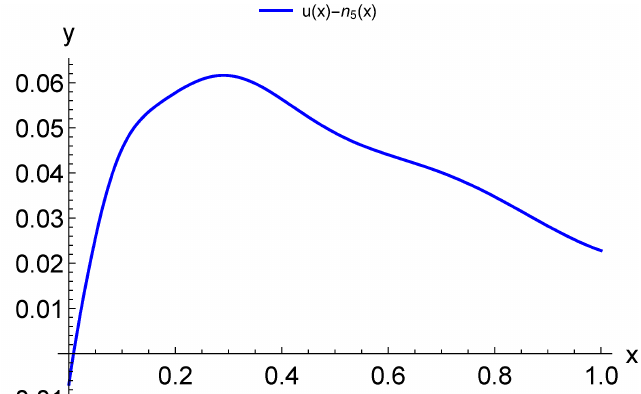
Figure 5. Plot of the error of the neural network solution n 5 ( x ) (9) (number of layers n = 5; sigmoid activation functions) as applied to problem (30), parameter value s = 0.1.